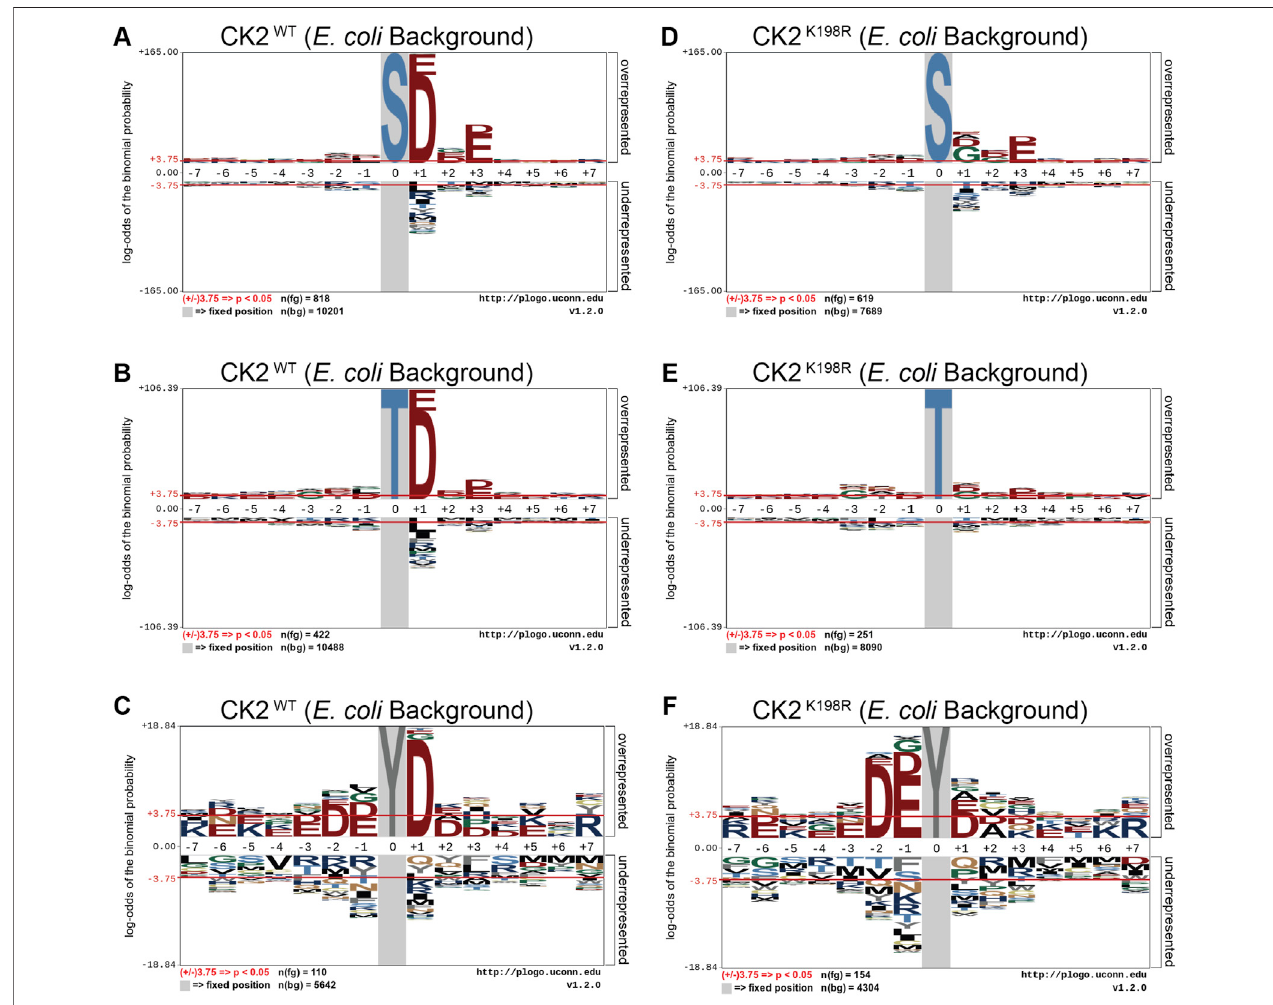
FIGURE 2 | CK2 K198R exhibits altered +1 substrate speci fi city . Substrate speci fi city of CK2 WT (A – C) and CK2 K198R (D – F) . The CK2 K198R mutation results in a decreased preference for acidic (D/E) residues in the +1 position for S and T centered phosphorylation sites. For Y centered phosphorylation sites, the preference for acidic residues is shifted to the – 2 and – 1